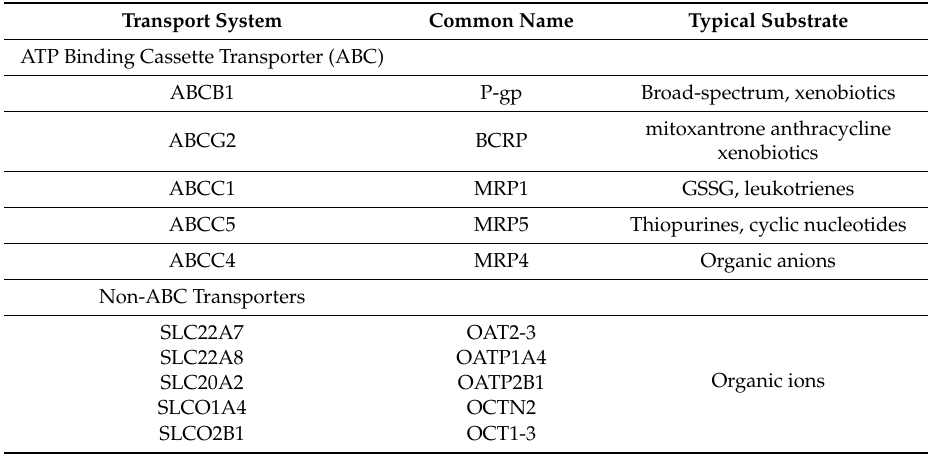
Table 2. Brain endothelial cell transporters of xenobiotics / drugs. Members of the ABC (ATP-binding cassette) superfamily of transporters demonstrated in brain endothelial cells and non-ABC transporters of organic chemicals potentially present are